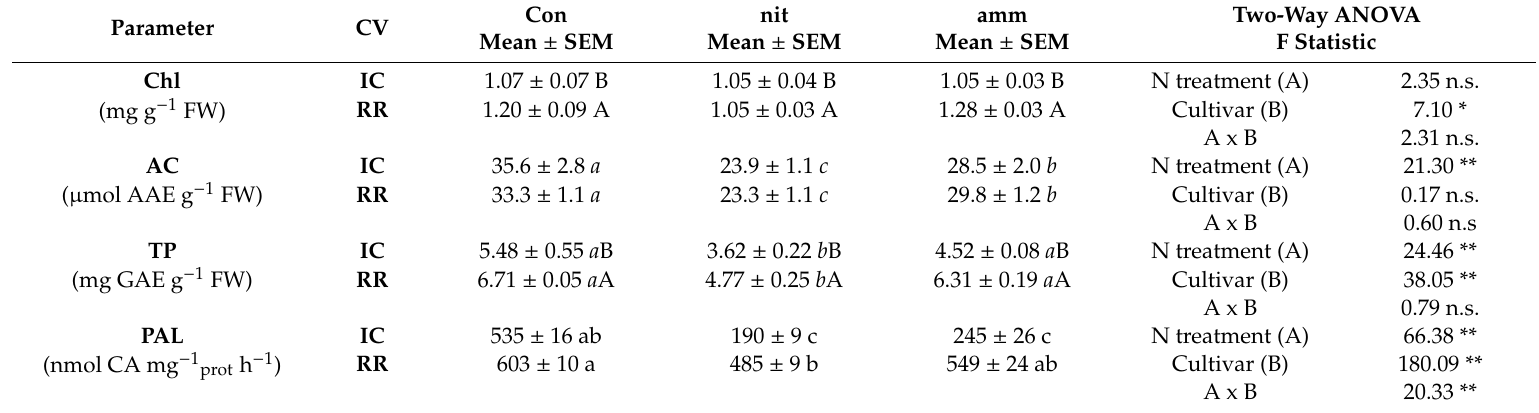
Table 2. Evaluation of total chlorophyll content (Chl), antioxidant capacity (AC), total phenols (TP), and PAL activity (PAL) in green and purple basil leaves. Plants of the green cultivar ‘Italiano Classico’ (IC) and of the purple one ‘Red Rubin’ (RR) were exposed for 5 d to absence of N—control [con], 10 mM NO 3 − —nitrate [nit],